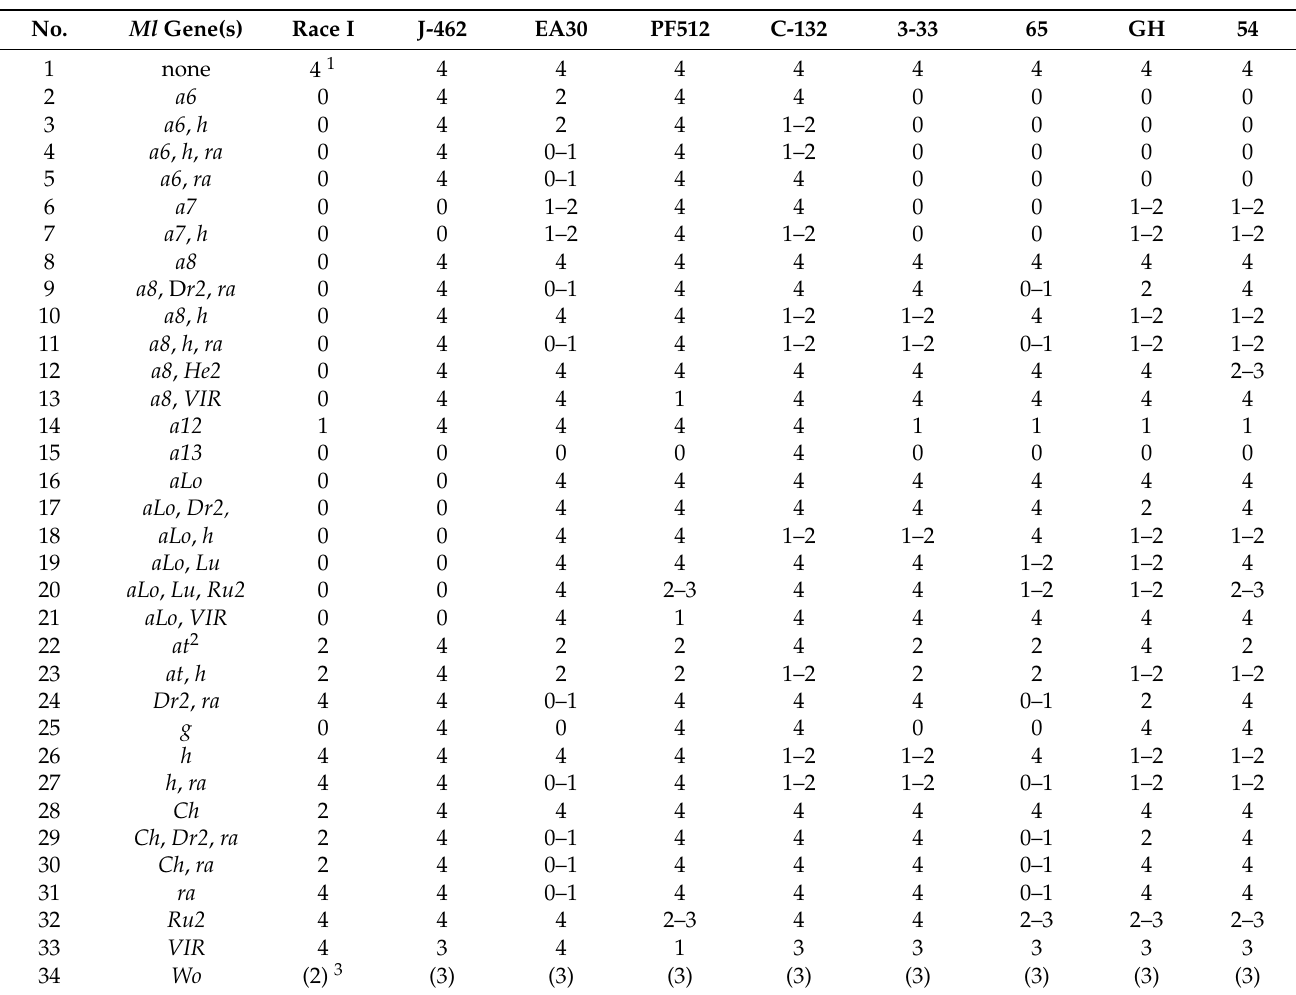
Table 1. Infection response arrays produced by nine Blumeria graminis f. sp. hordei isolates on 34 barley genotypes and their powdery mildew resistance genes.